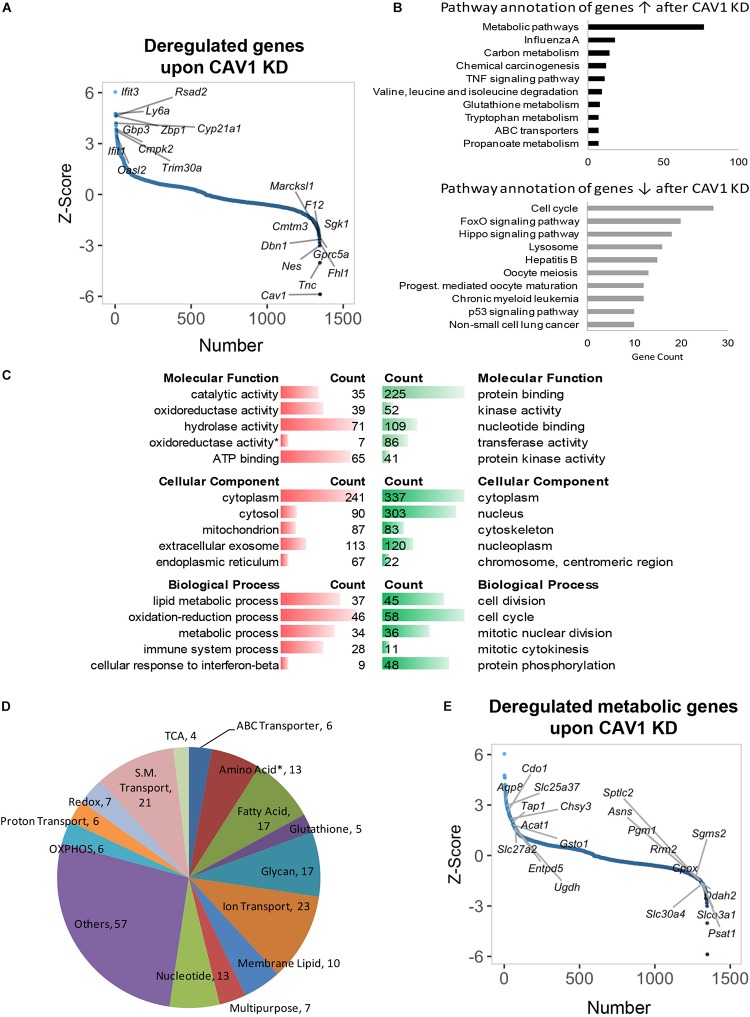
Gene expression profiling and deregulated metabolic genes upon CAV1 knockdown in primary hepatocytes after 48 h. (A) Distribution of altered genes by Z-score (N = 1348, highlighted top 10 upregulated and top 10 downregulated genes). (B) KEGG pathway annotation of total deregulated genes indicated that CAV1 knockdown caused upregulation of metabolic processes. (C) Molecular functions, biological processes, and cellular component analyses of total deregulated genes. (D) Classification of 229 deregulated metabolic genes in biochemical metabolic processes. (E) Distribution of deregulated genes by Z-score (N = 1348, highlighted metabolic top 10 upregulated and top 10 downregulated genes). Data from each analyzed group was from a mixture of three mice. ↑, upregulated; ↓, downregulated; red, upregulated; green, downregulated. ∗, all amino acids besides glutamine and serine.